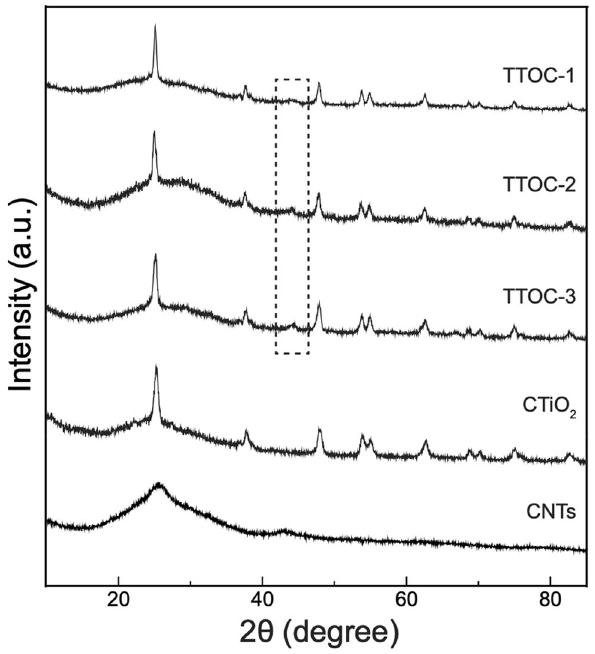
Figure 3. XRD patterns of the as-synthesized nanocomposites (TTOC-1, TTOC-2, and TTOC-3), commercial